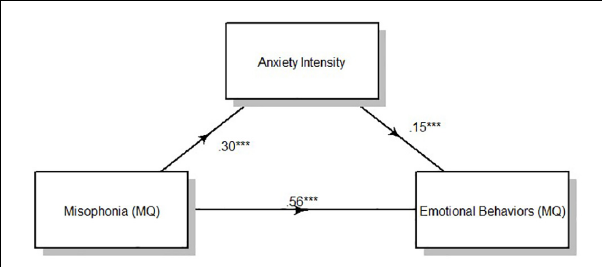
FIGURE 2 | Overall mediation model for anxiety intensity. Standardized path coefficients. *** p < 0.001, all two tailed.